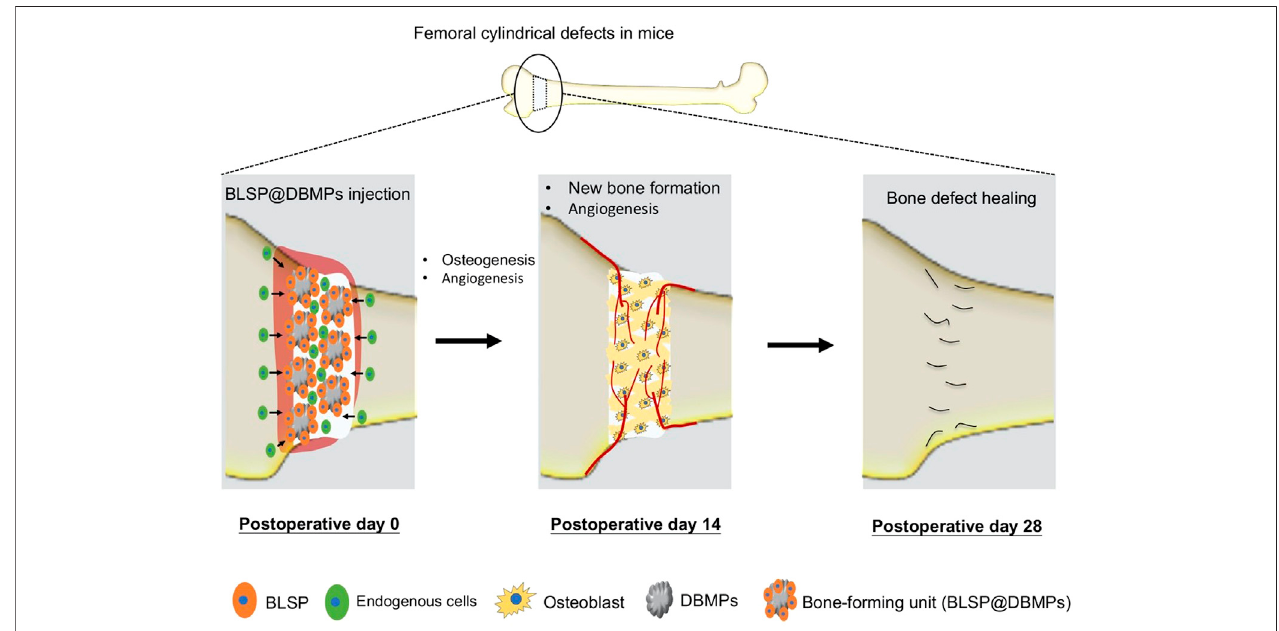
FIGURE9| Schematicillustrationoftheapplicationofthebone-formingunitsinbonedefecthealingandtheirpotentialmechanisms.TheimplantedBLSPattaching totheDBMPssecreteaseriesofbioactivesubstancesstimulatingangiogenesisatthebonedefectsite,andtheDBMPsinthebone-formingunitsstimulatetheattaching BLSP down into the osteogenic lineage, thus promoting bone defect healing.